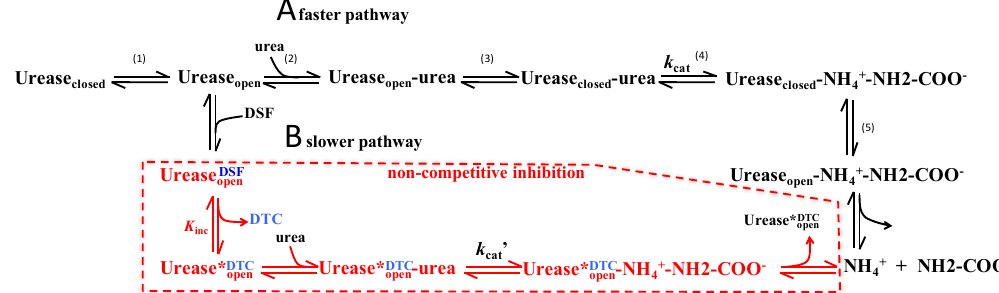
Figure 6. Scheme of the proposed kinetic mechanism for the inhibition of urease enzymes by disulfiram. ( A ) In the absence of inhibitor urea binds to urease in the open conformation; followed by the change to the closed conformation and allowing general base to accommodate in the correct position; subsequently the hydrolysis is produced and the flap changes to the open conformation; allowing the release of products and water/-OH exchange. ( B ) In the presence of DSF, formation of adduct with urease in the open conformation impedes the full closure of the flap and thus DSF derivative obstructing the accommodation of the general acid producing a less active form of urease. Urease*DTC-open is the proposed form of the trapped enzyme as opposed to a not fully-closed or fully-open inhibited conformation.